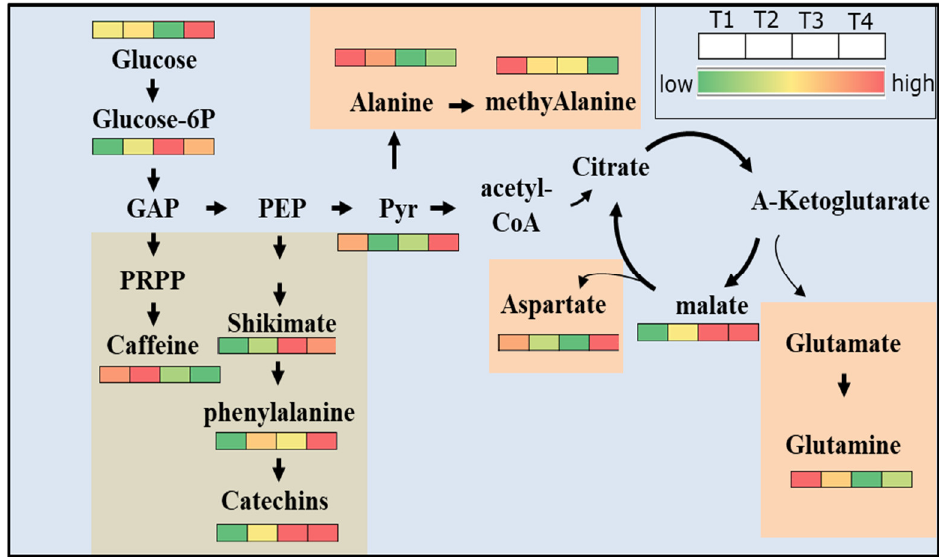
Figure 7. Schematic presentation of the analysis of the phenylalanine metabolism/flavonoid biosyn- thesis pathway in young tea shoots under different fertilization treatments.